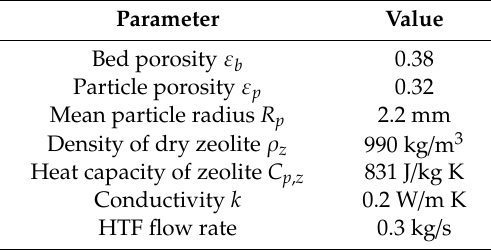
Table 2. Properties of the zeolite 13X and process